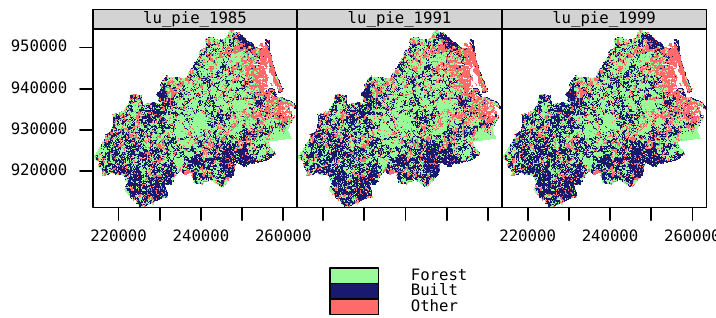
Figure 3. Observed land use maps for the Plum Island Ecosystems site in 1985, 1991 and 1999, created by plotting the ObsLulcRasterStack object representing the